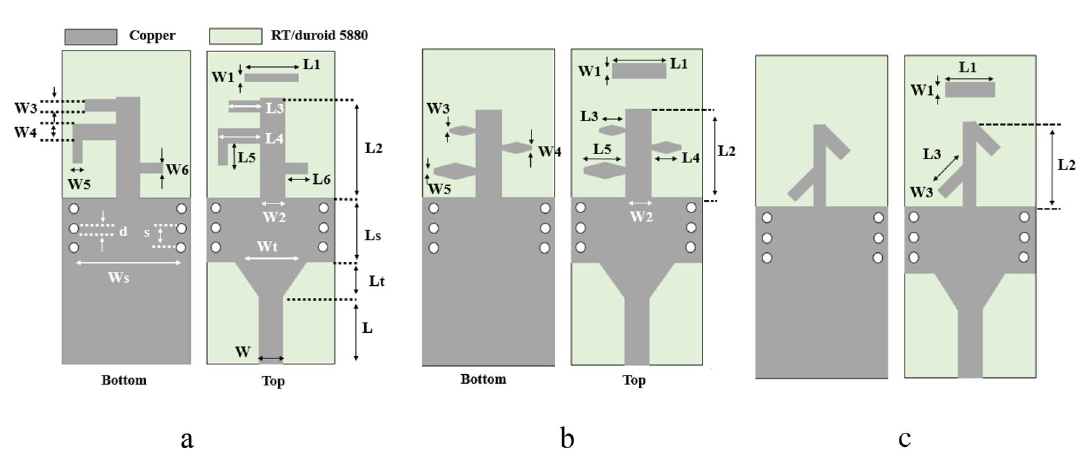
Figure 4. Structure of the proposed single element ( a ) antenna1, ( b ) antenna2 and ( c ) antenna3 21